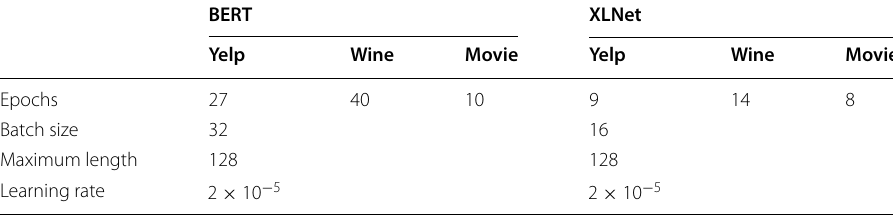
Table 6 The setup of the transfer learning